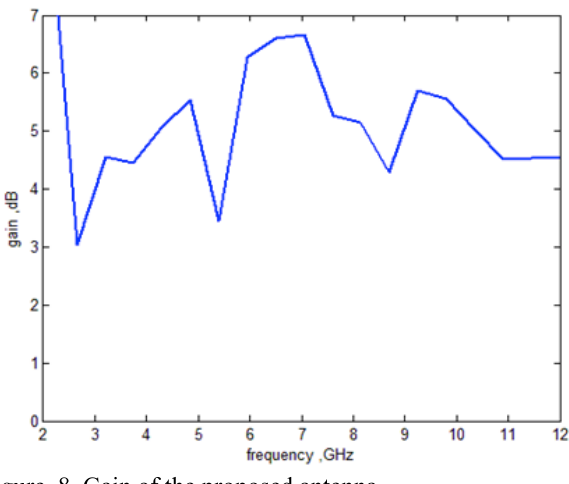
Figure 8. Gain of the proposed antenna.